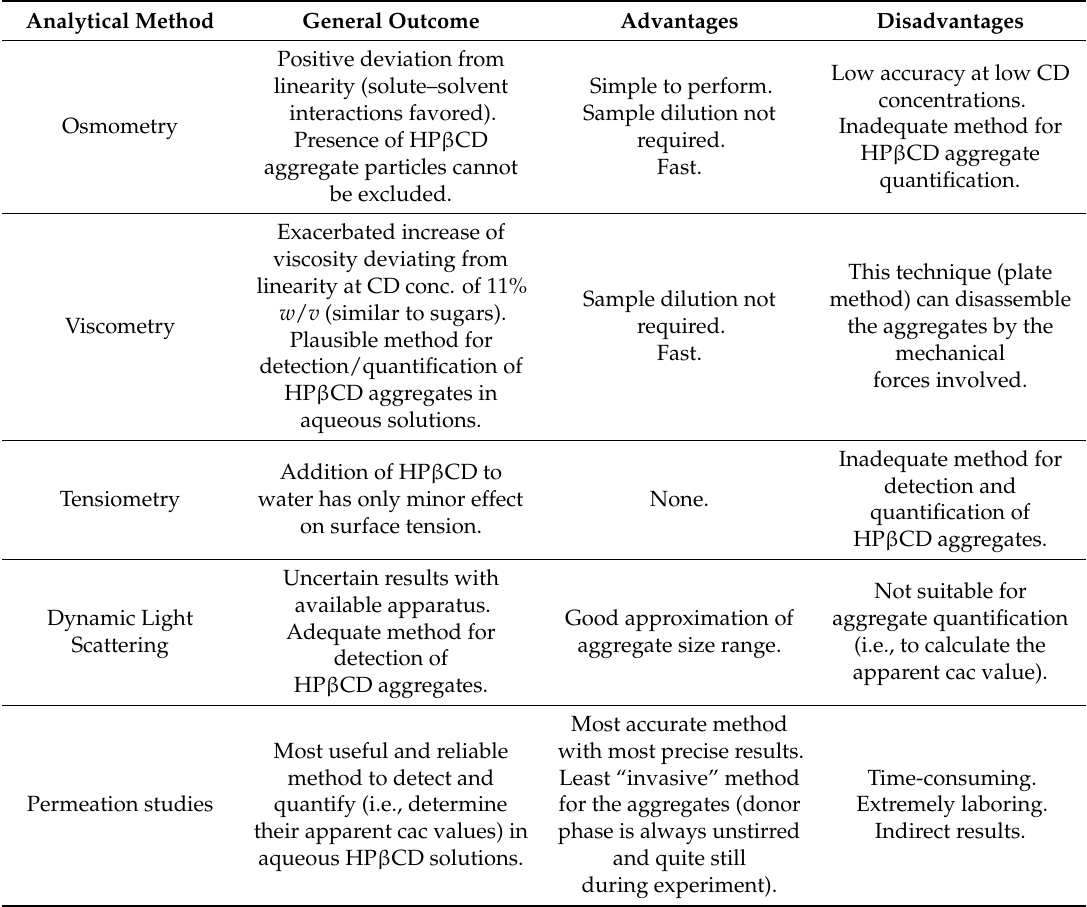
Table 3. Schematic table of main results, advantages, and disadvantages of assessed analytical